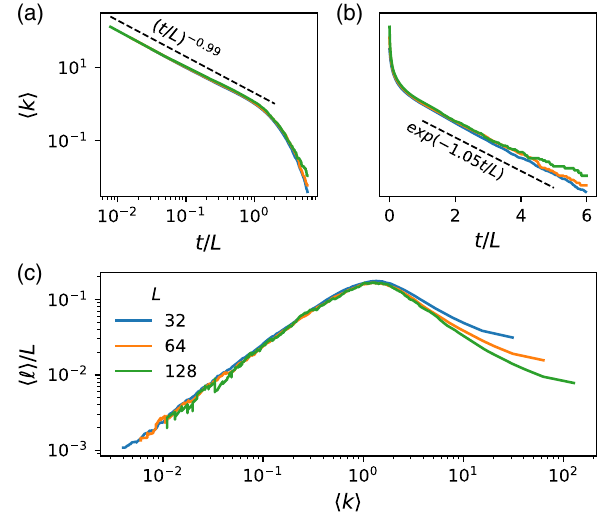
FIG. 10. Quantum code properties of a critical MOM [the r ¼ 2 1 ; 1 ; 1 Þ point], factorizable model in Fig. 4(b) at the q ¼ 1 3 ð averaged over 10 3 realizations of the dynamics. (a),(b) Average number of encoded qubits, h k i , as a function of time starting from the fully mixed state. h k i depends only on t=L (dynamical exponent z ¼ 1 ) and decays as L=t at early times (a) and exponentially at late times (b). (c) Average contiguous distance h l i as a function of h k i (time progresses right to left). The distance peaks (and becomes extensive) when h k i ≃ 1